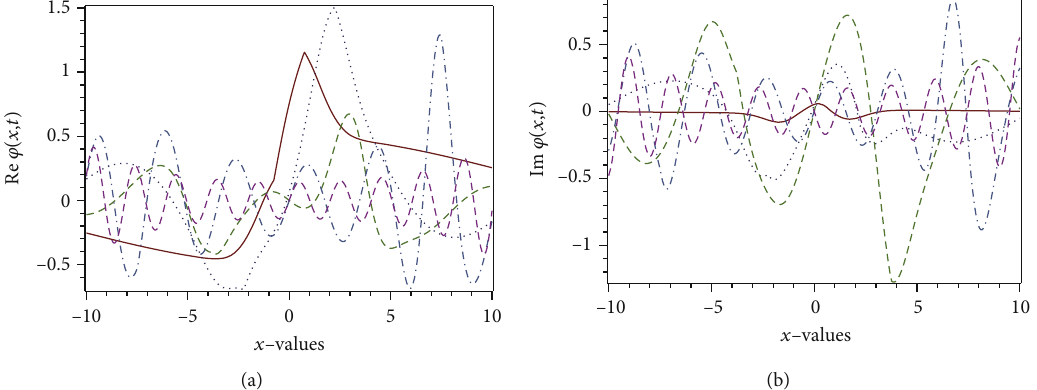
Figure 2: Real and imaginary parts of solution of (43) for a = 1/2, b = 2, k = 3/2, t = 1/2, t = 3/2, t = 5/2, t = 5, t = 8, and g ð x Þ = signum ð x Þ .